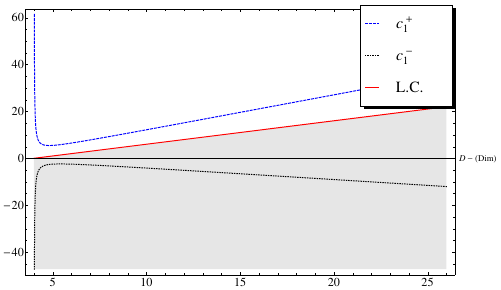
(dashed blue line), c ( (cid:0) ) (doted black line) and the 1 1